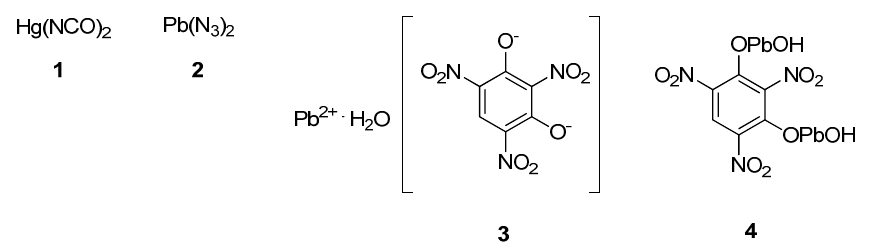
Figure 1. Chemical structure of the primary explosives; mercury fulminate (1), lead azide (2) and normal lead styphnate (3) and basic lead styphnate (4).